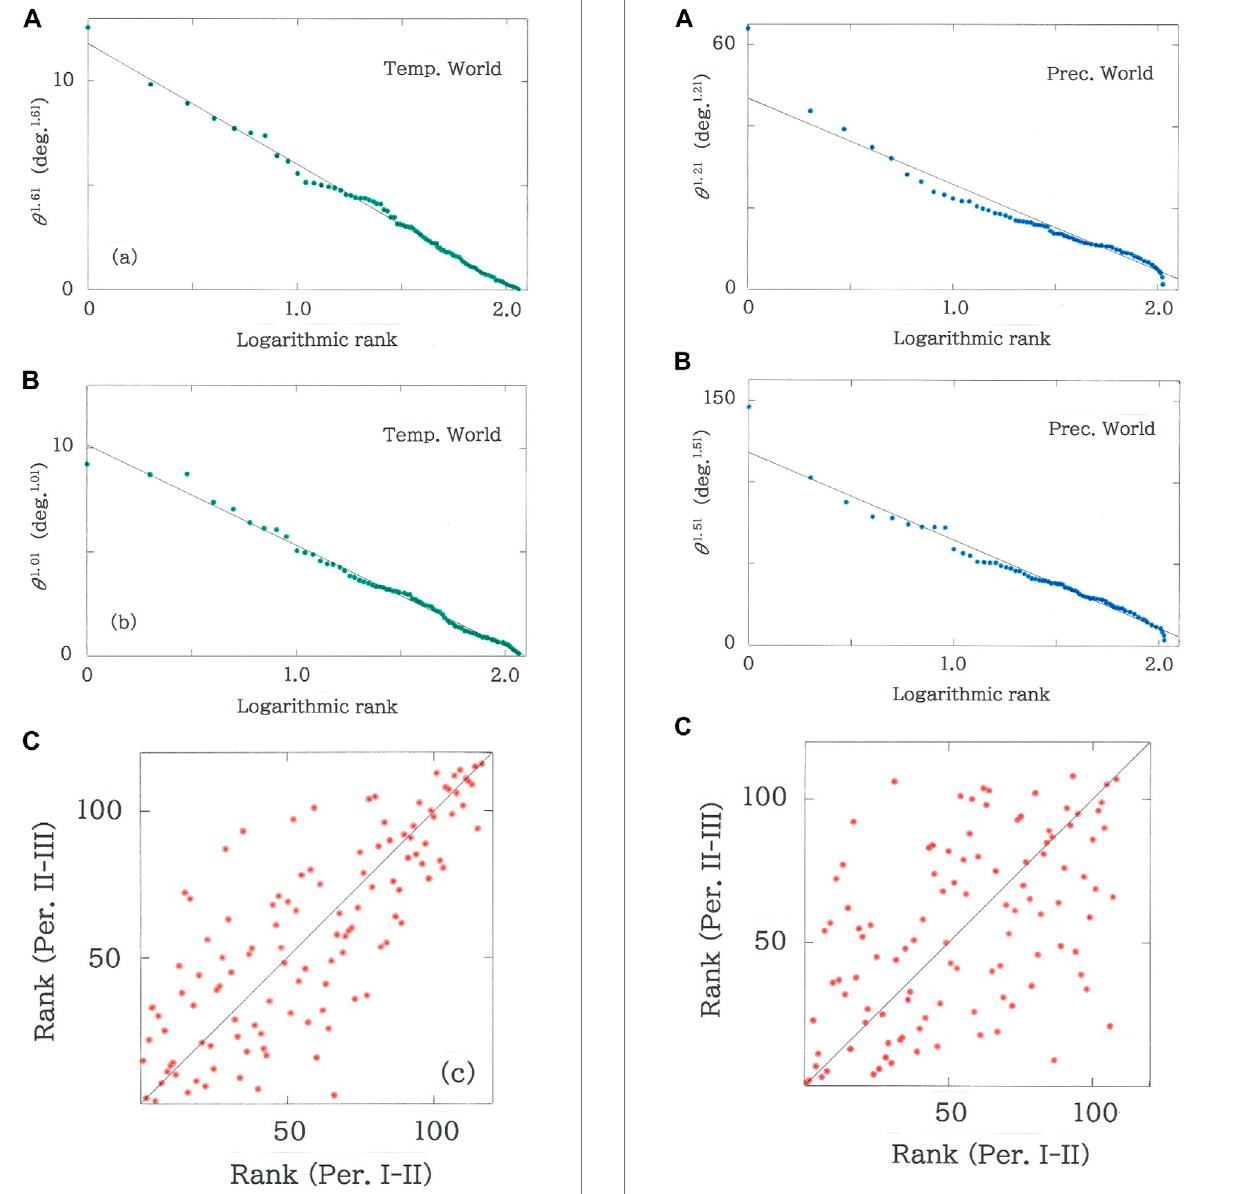
Global Analysis Computed results of the temperatures and precipitations, respectively, are given in Figures 3 , 4 . In both cases, of the